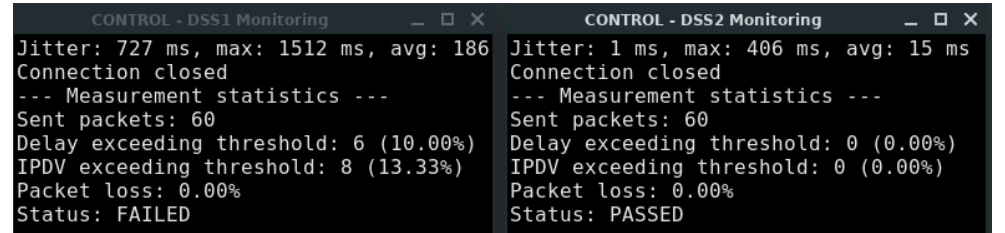
Figure 7. Results of the quality measurement scripts run in two DSS (DSS1 under a DoS attack, DSS2 operating